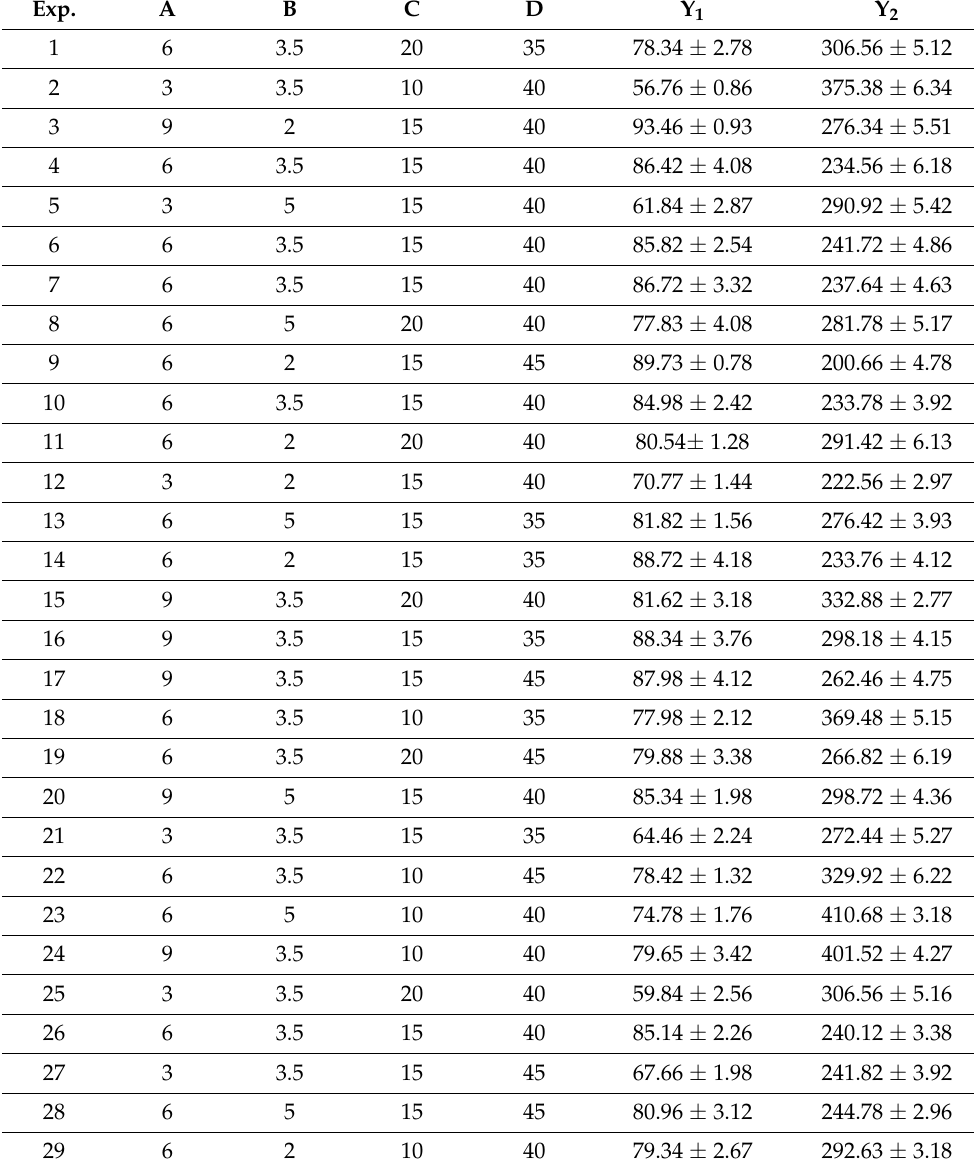
Table 2. Observed responses of trial experiments as per